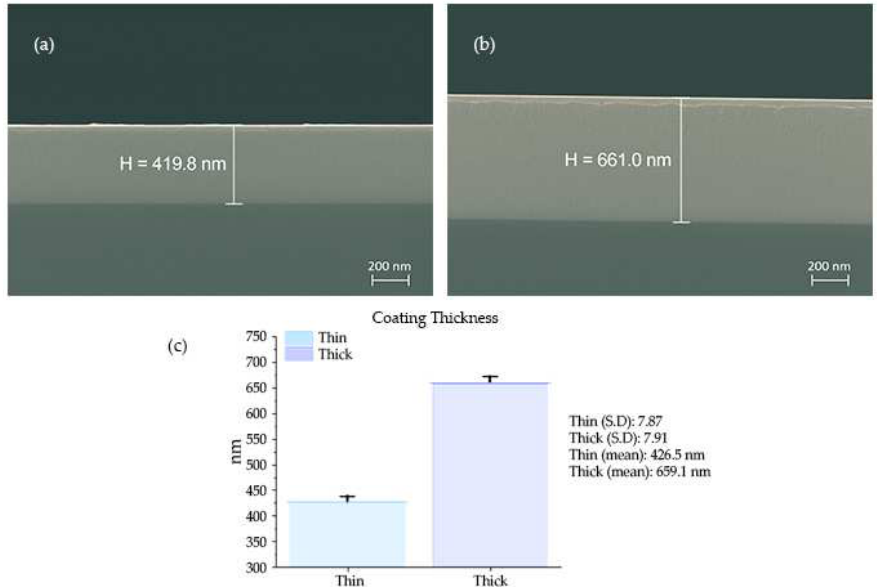
Figure 2. SEM analysis of HEA thin films synthesized at two different ion densities of ( a ) 20 µAcm −2 (thin film) and ( b ) 50 µAcm −2 (thick film). ( c ) Statistical differences between these two coatings.